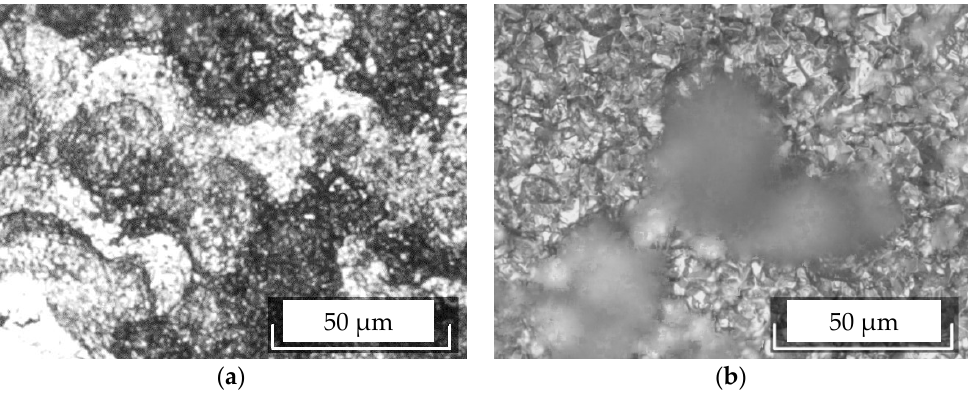
Figure 9. Specimen surface morphology: ( a ) CPC No. 2 (NaCl–KCl–NaF (10 wt %)–K 2 NbF 7 (8 wt %), i = 1 × 10 − 2 A·cm − 2 , τ = 8 h, t = 750 ° С ); ( b ) CPC No. 3 (the same melt, i = 2 × 10 − 2 A·cm − 2 , τ = 10 h, t = 750 ° С ).